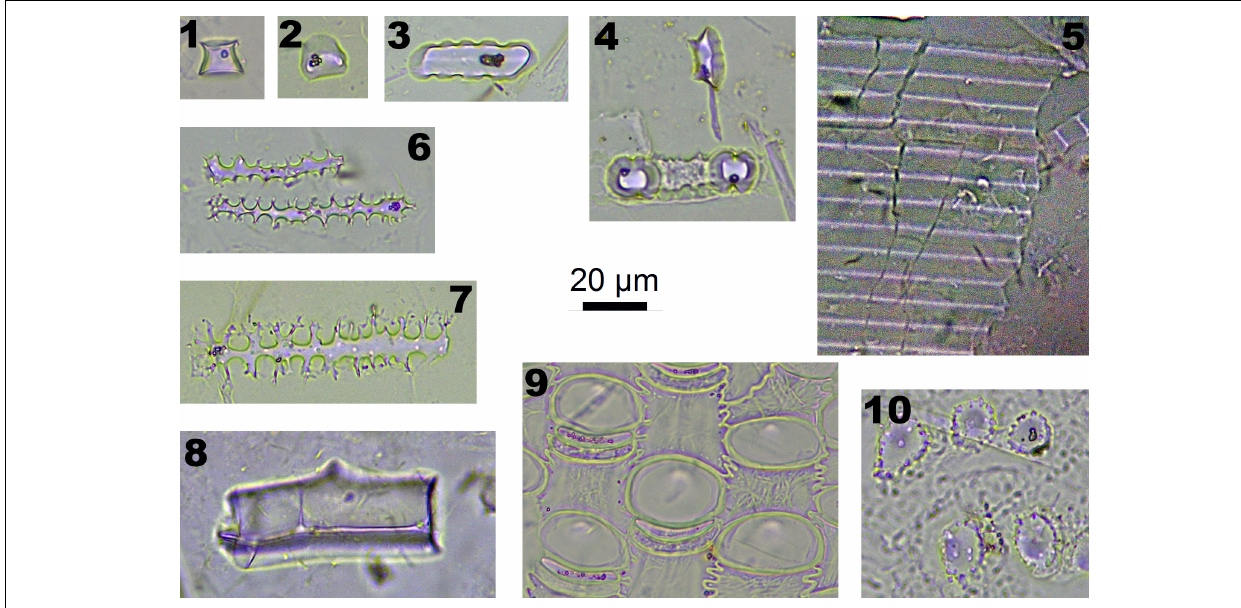
FIGURE 2 | Phytoliths morphotypes in Pooideae plants. 1. R ONDEL CONICAL ; 2. R ONDEL CARINATE ; 3. C RENATE SINUATE ; 4. B ILOBATE SADDLE ; 5. S ILICIFIED EPIDERMIS ; 6 and 7. E LONGATE DENDRITIC ; 8. B LOCKY ; 9. P APILLATE CIRCULAR ; and 10. P APILLATE RADIATE .